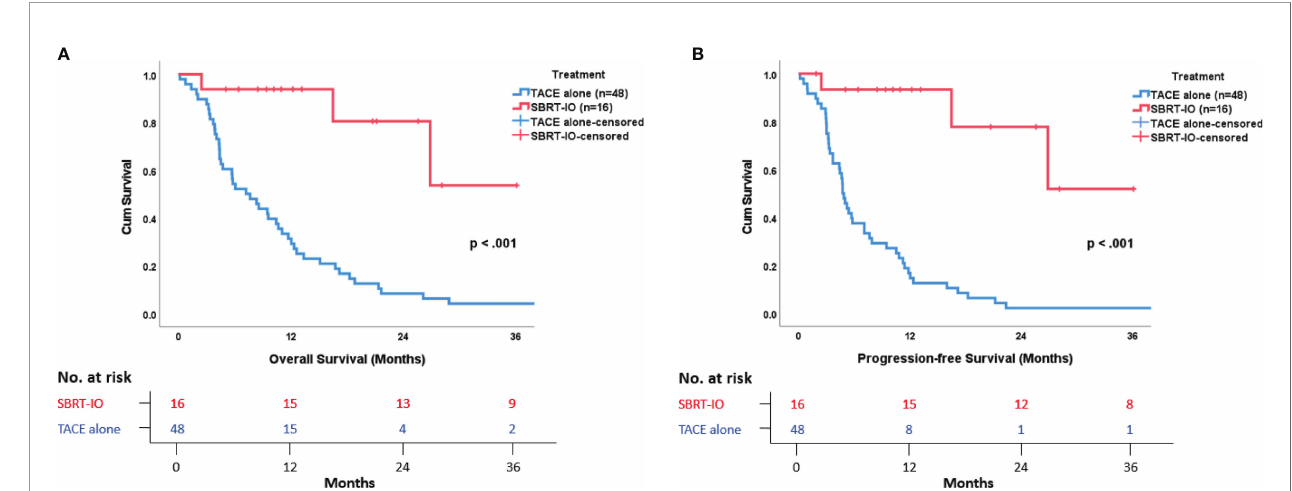
FIGURE 1 | Survival Outcome in Patients with Locally Advanced Unresectable Hepatocellular Carcinoma. (A) Overall survival and (B) Progression-free survival are remarkably and signi fi cantly better in SBRT-IO group versus matched TACE